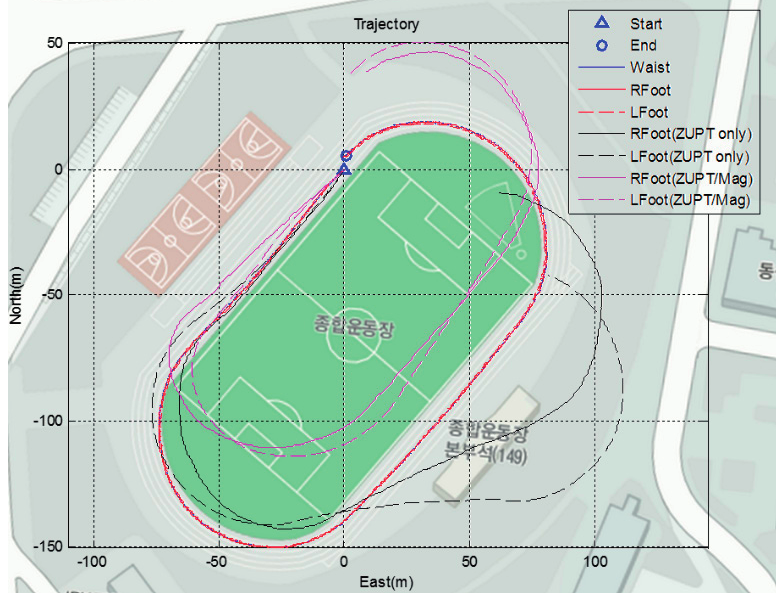
Figure 17. Result of playground trajectory test of each algorithm (total distance = 400 m).